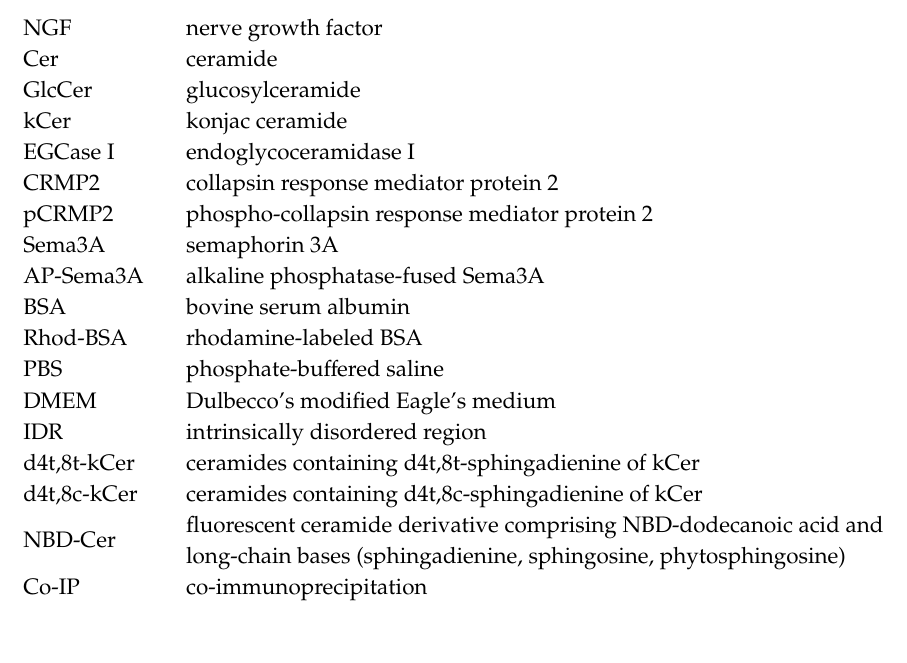
Figure S1: Long-chain bases for d18:2 4t, 8t , d18:2 4t, 8c , d18:1 4t , and t18:0 (shown in Figure 1A), Figure S2: Dot blot analysis of d4t,8t-NBD-Cer and a1a2, Figure S3: Interactions between d 4t,8t-C16Cer and the a1a2 domain, Figure S4: Molecular docking of d4t,8t-C16Cer and the a1 module at site A, Figure S5: Purity of the recombinant